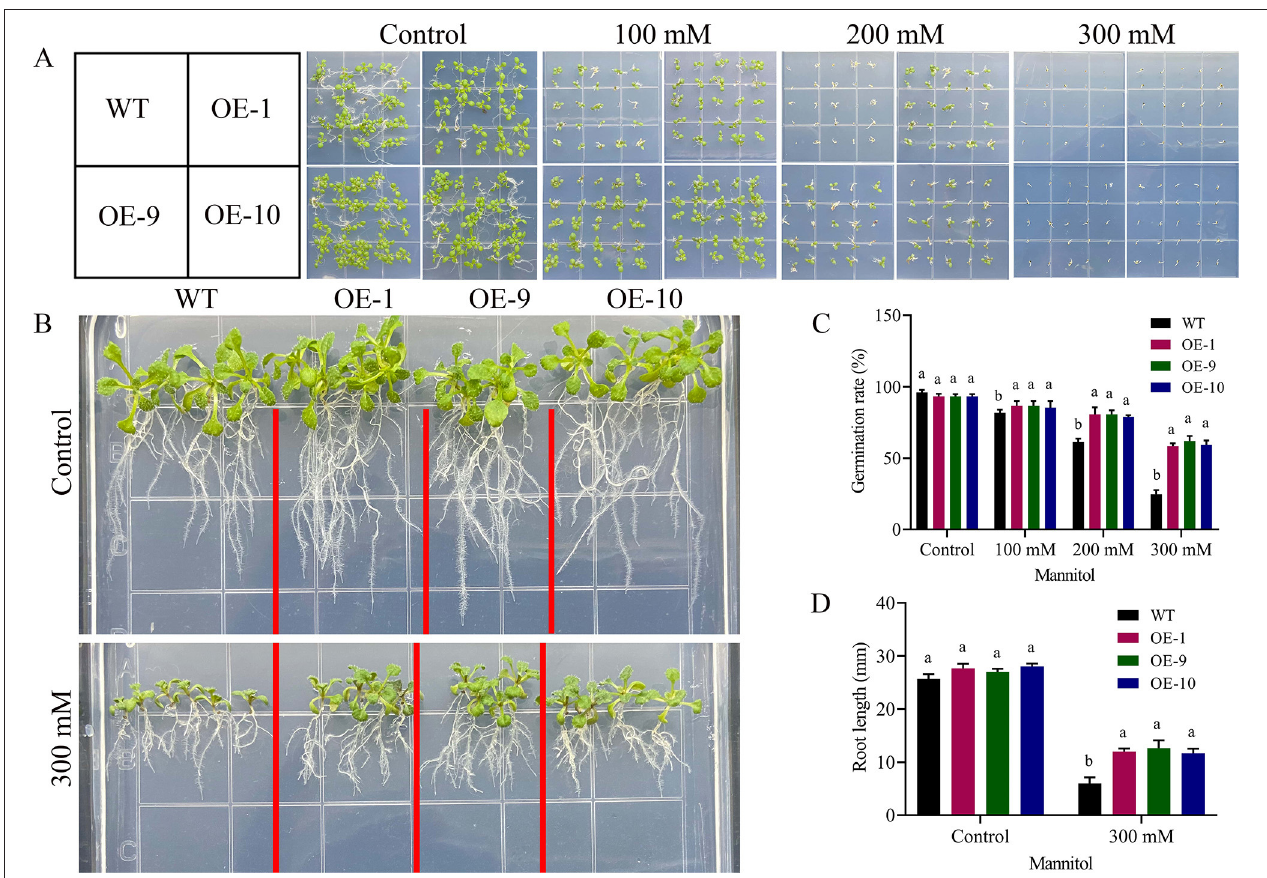
FIGURE 5 | Germination and root length determination (A) Arabidopsis has grown on MS medium with 100mM, 200mM, and 300mM mannitol evaluation. (B) Root length determination after drought treatment (C) Germination assays of Arabidopsis growth in different concentrations of mannitol, (D) Root length determination of Arabidopsis growth in 0- and 300-mM concentrations of mannitol. The error bars reflect the standard error. Using the LSD, means on the same graph, with the similar letter are not significantly different at the 5% probability level. LSD, the least significant difference. OE, overexpressed; WT, wild-type; mM; millimole.